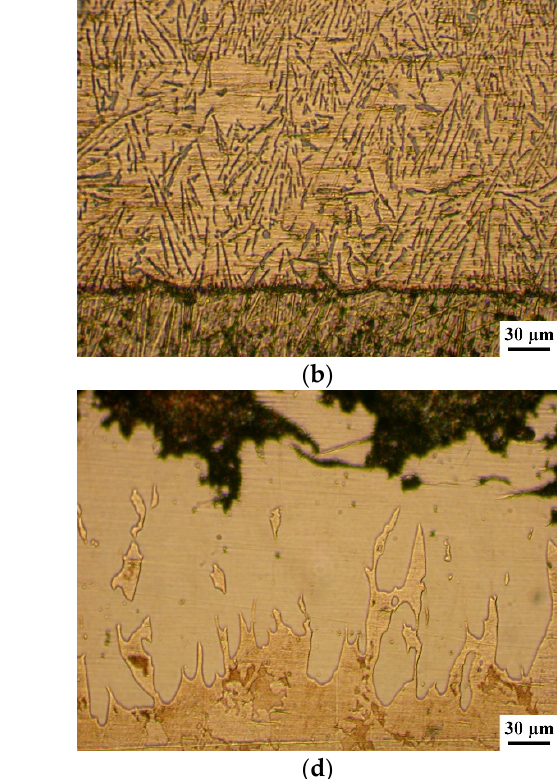
Figure 3. Structure of a combined coating of the AlSi12 alloy with a lead sublayer: ( a ) the structure of the middle part of the coating; ( b ) the coating structure at the border with the lead sublayer; ( c ) the sublayer structure; ( d ) the structure of the diffusion layer on the steel base.